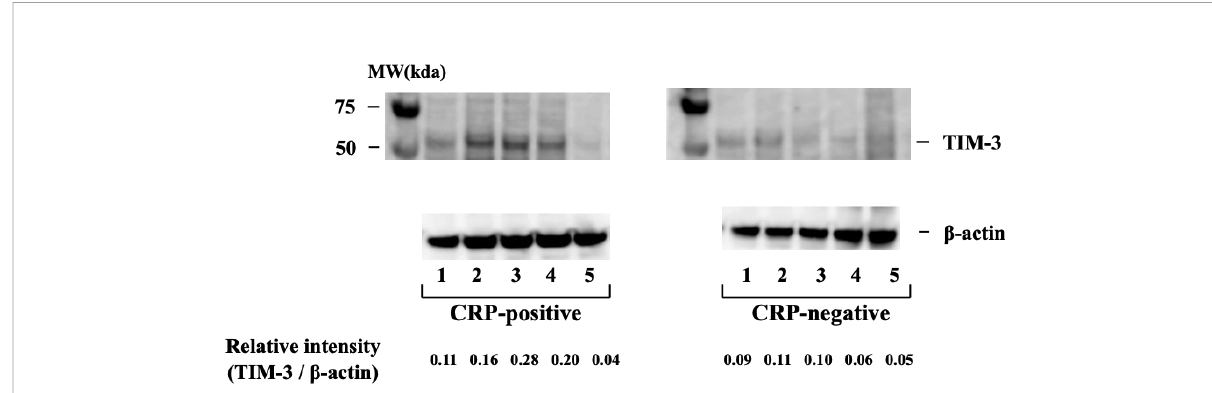
FIGURE 7 Intracellular expression of TIM – 3 in neutrophils isolated from RA patients with or without in fl ammatory sign (CRP >0.30 mg/dL). Intracellular expression of TIM – 3 was determined by Western blotting using neutrophils cellular lysate in RA patients with or without elevated serum CRP levels. TIM – 3 expression was normalized b – actin bands and the ratio of TIM – 3 to b – actin was calculated. They indicate that the intracellular expression of TIM – 3 was similar between active and inactive patients with RA. RA, rheumatoid arthritis; CRP, C-reactive